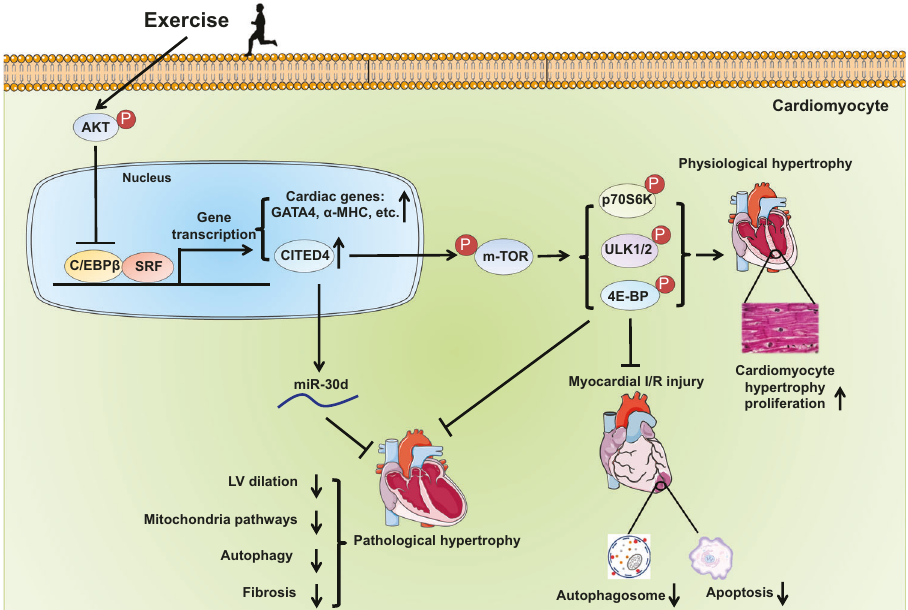
Fig. 3 The C/EBP β /CITED4 pathway in exercise-induced physiological cardiac hypertrophy and exercise-induced cardioprotection. Exercise leads to downregulation of the transcription factor C/EBP β which is associated with increased AKT activity in the heart. The C/EBP β interacts with SRF binding to the promoters of cardiac genes (e.g., GATA4 and α -MHC) and CITED4, leading to a negative transcriptional regulation of these genes. Increased CITED4 can act as a regulator of mTOR signaling with increased phosphorylation of p70S6K, ULK1/2, and 4E-BP, which mediates the bene fi cial effects of CITED4 in promoting physiological cardiac hypertrophy and preventing cardiac I/R injury. Increasing CITED4 is also able to prevent pathological hypertrophy through activating the mTOR pathway and upregulating anti- fi brotic miR-30d. C/EBP